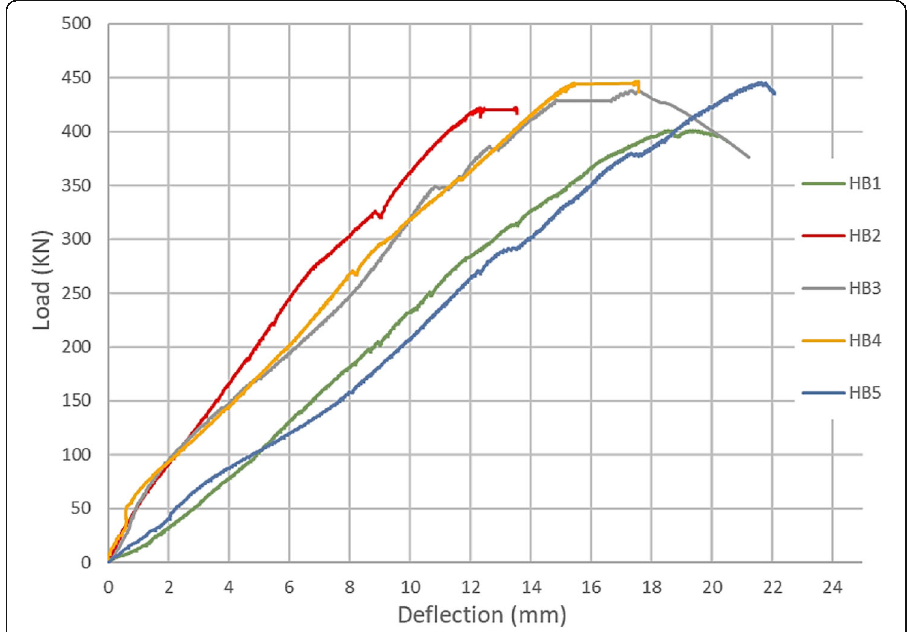
Fig. 13 Load deflection at mid-span of tested beam specimens HB1, HB2, HB3, HB4, and